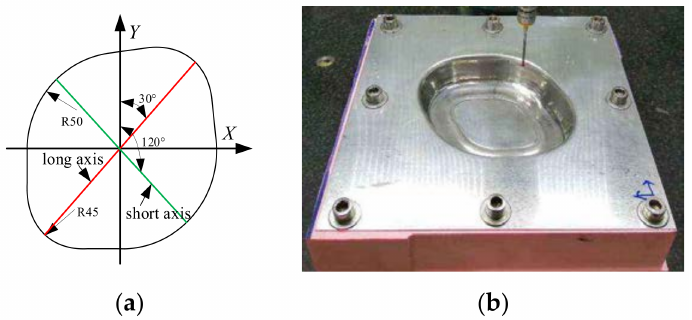
Figure 20. Profile measurement: ( a ) measurement position and ( b ) measurement